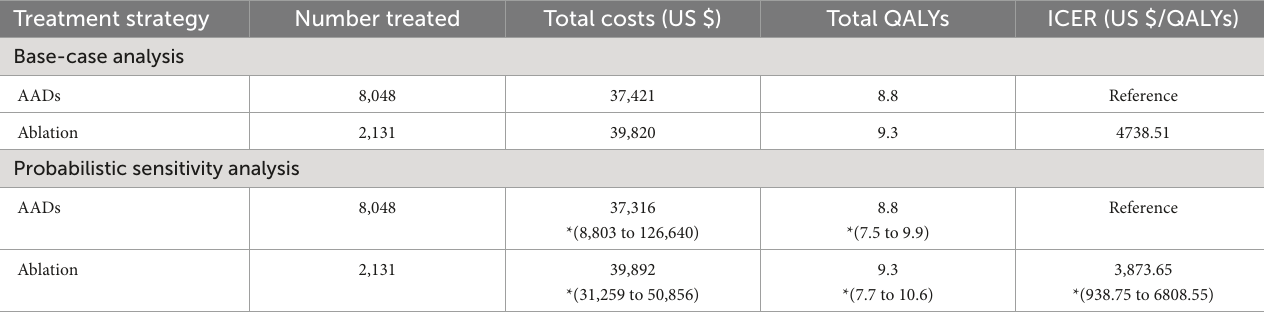
TABLE 2 Base-case and probabilistic sensitivity analyses (PSA) result of AF rhythm control strategies. Treatment